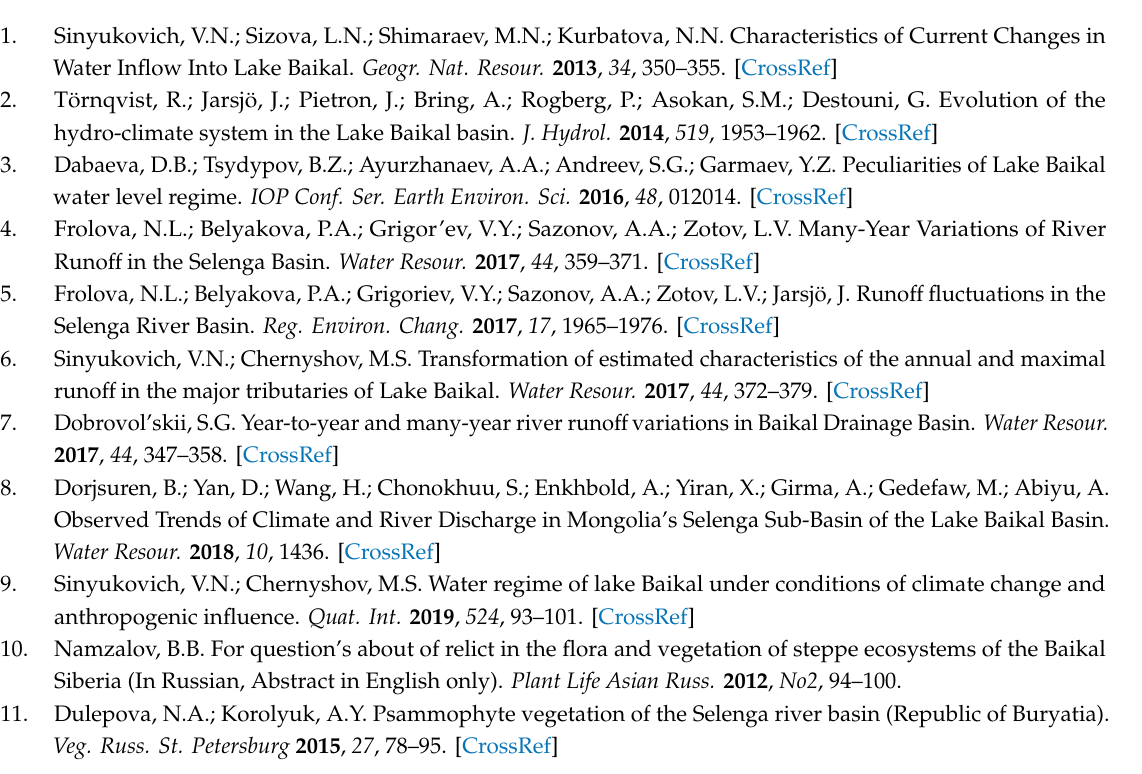
Table S1. The MCD12C1 International Geosphere-Biosphere Program (IGBP) legend and class